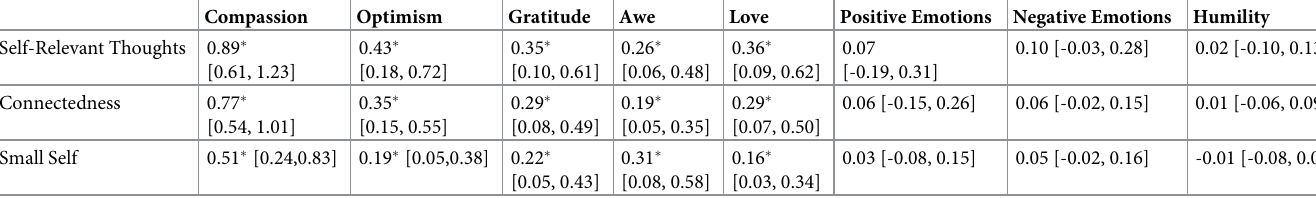
Table 6. Indirect effects of self-transcendent emotions on self-relevant thoughts, connectedness, and small self (Study